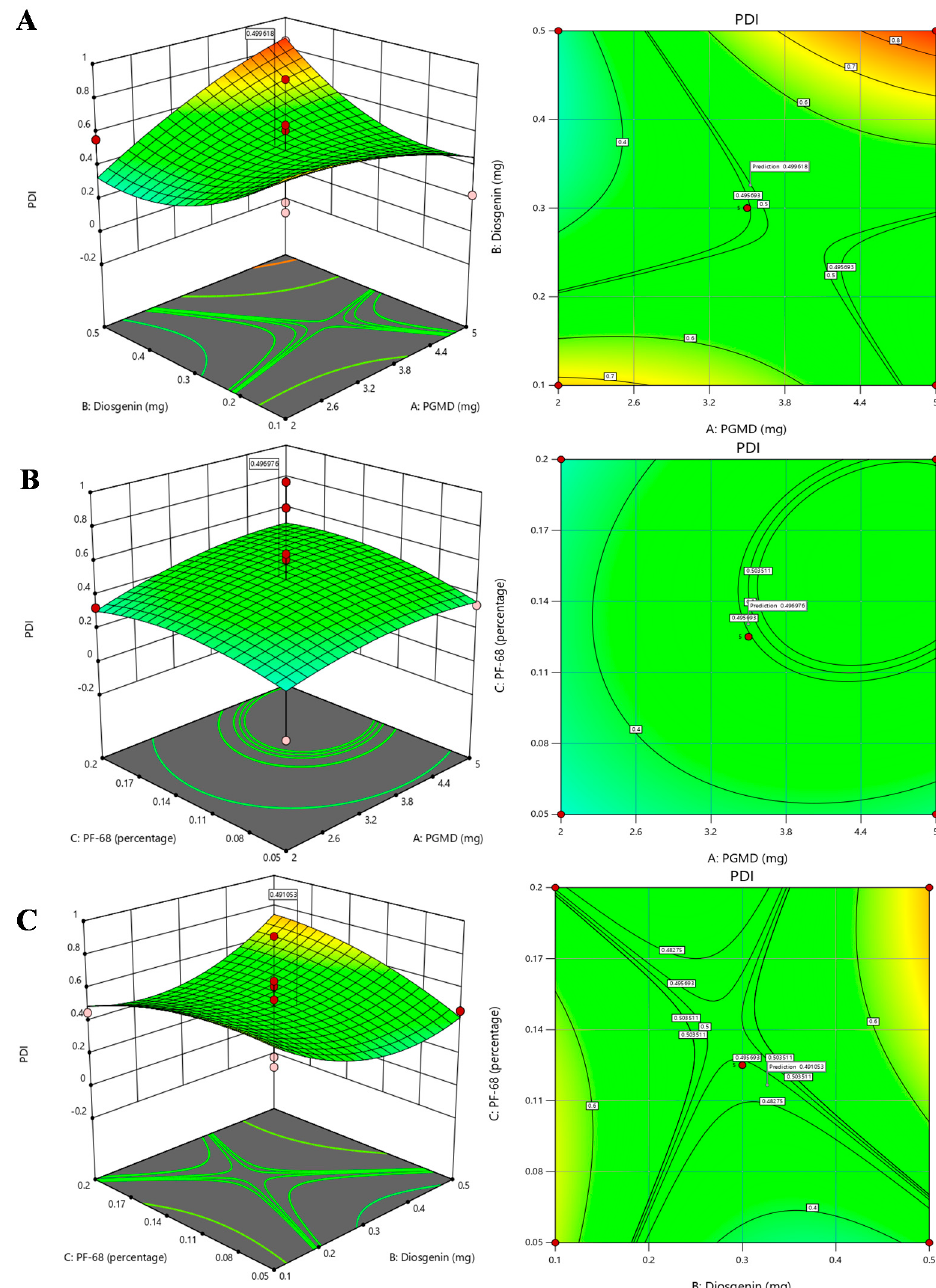
Figure 3. 3D response surface plots and 2D contour plots depicting the effects of factors: PGMD, Diosgenin and Pf-68 concentrations on PDI, ( A ) PGMD vs. Diosgenin; ( B ) PGMD vs. PF-68 and ( C ) Diosgenin vs. PF-68.